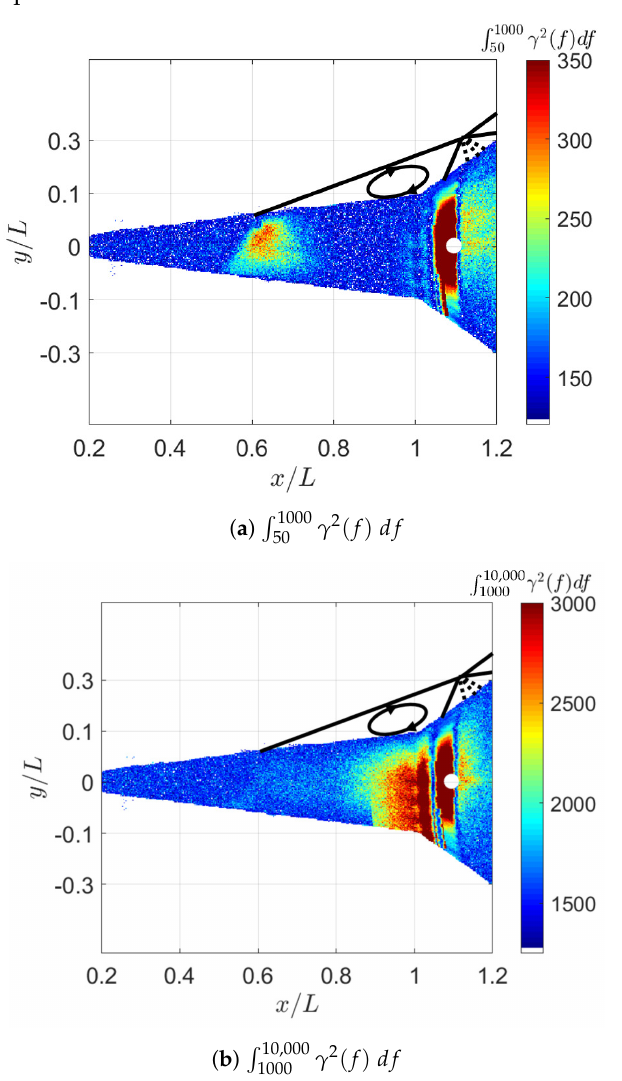
(cid:82) Figure 6. Band-limited γ 2 ( f ) df contours. Global contours of band-limited phase between the reattachment shock foot and every pixel on the model were created in a similar fashion by calculating the mean value of | φ | for the characteristic low-frequency (i.e., 50 < f < 1000 Hz) band (Figure 7). The phase spectrum was dominated by noise for the high-frequency (i.e., 1000 < f < 10, 000 Hz) band, and is therefore not